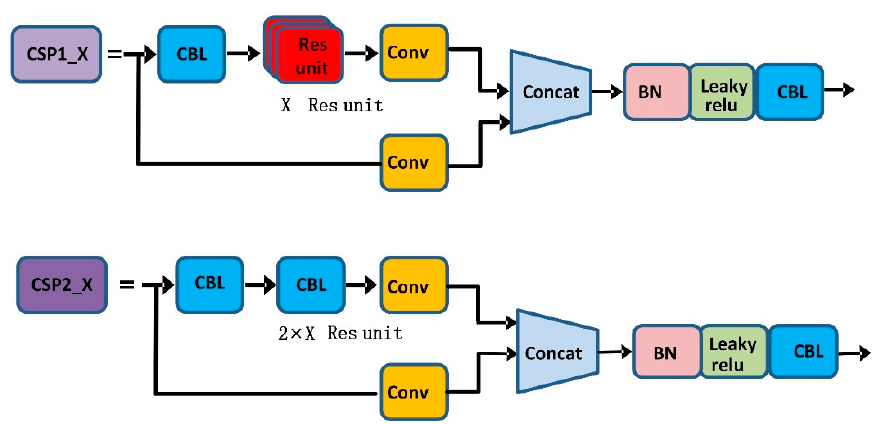
Figure 4. CSP1_X and CSP2_X structures.